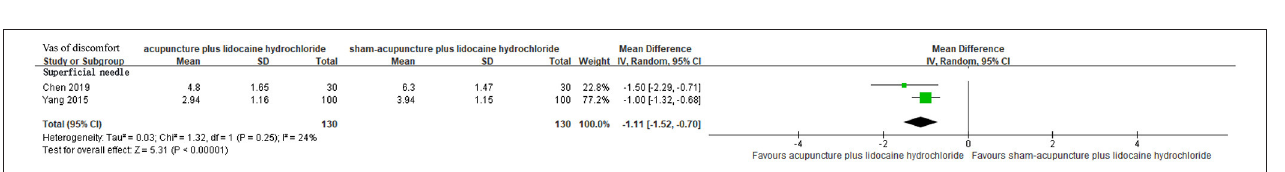
reported the rate of patients willing to repeat the procedure in the EA plus TPALH group was approximately seven times higher than that in the control group (RR 6.92, 95% CI 2.23–21.47; P =